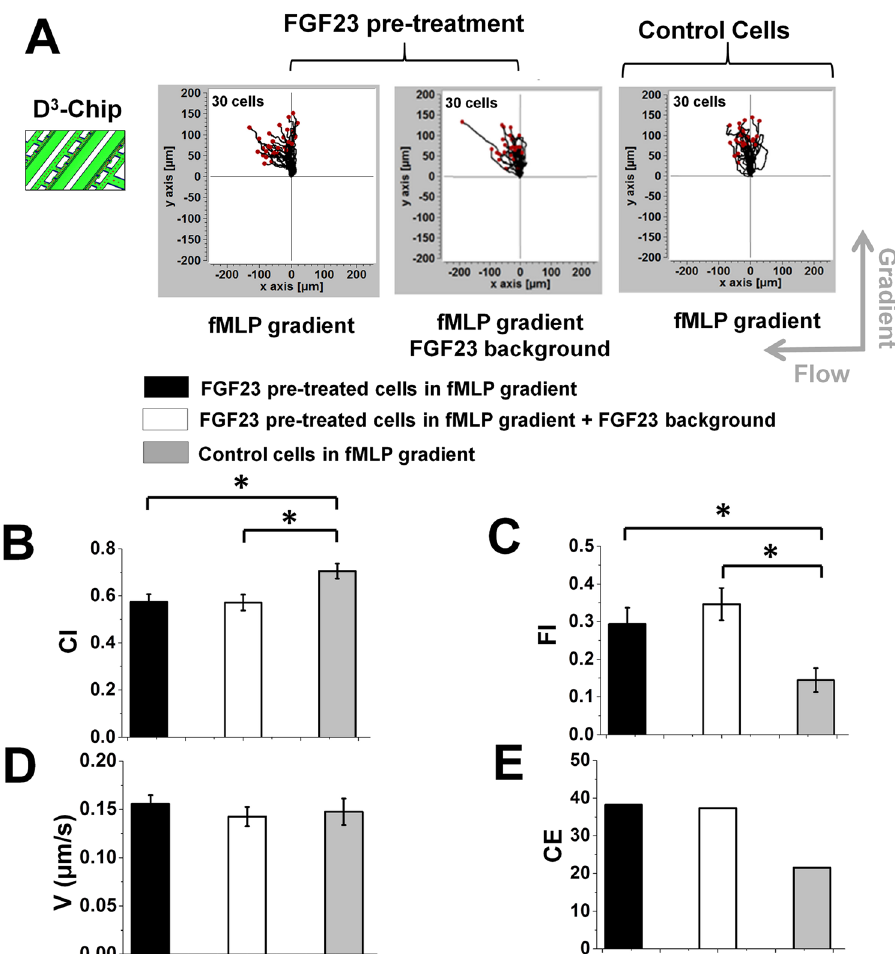
Figure 4. Chemotaxis of FGF23 pre-treated cells and un-treated control cells in the D 3 -Chip. ( A ) Cell migration tracks of FGF23 pre-treated cells in a 100 nM f MLP gradient with or without a FGF23 uniform background (left two plots) and cell migration tracks of control cells in a 100 nM f MLP gradient (right plot) in the D 3 -Chip. The cell tracks are normalized to have the same starting point in the plot. The gradient direction, the flow direction and the number of cells for each plot are indicated; ( B – E ) Comparison of quantitative cell migration parameters including chemotactic index (CI), flowtactic index (FI), speed (V) and chemotactic entropy (CE). The data for each parameter are presented as the average of all cells from representative experiments. The error bar indicates the standard error of the mean. * Indicates p < 0.05 for comparison between specific conditions using the Student’s t